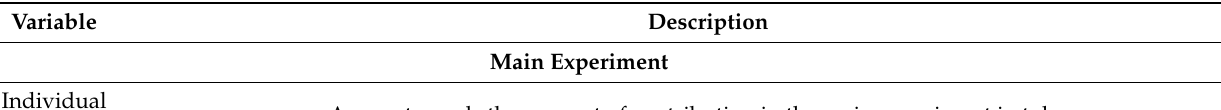
Table A3. Overview of